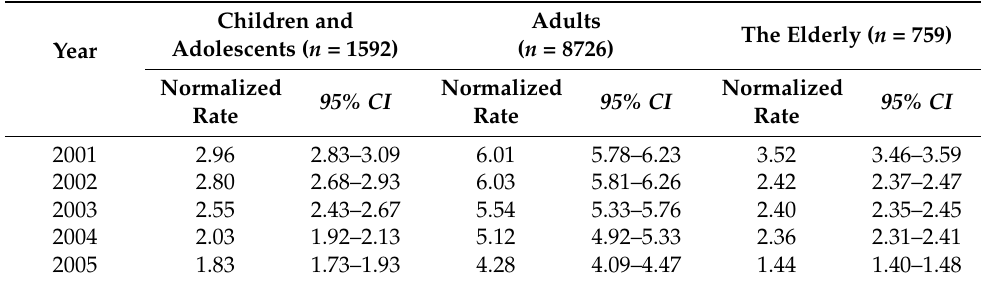
Figure 2. Standardized rates of initial violence-related medical visits among Children and Adolescents, Adults, and The Elderly.